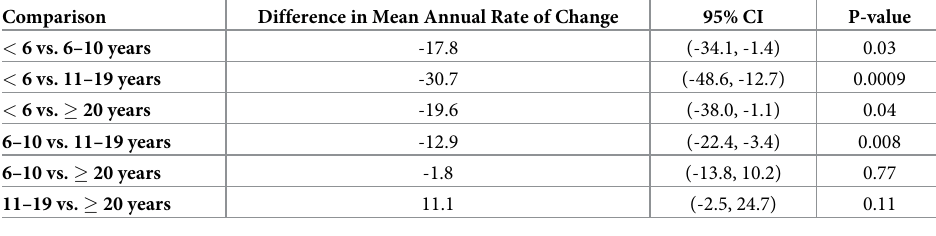
Table 3. Age group comparisons of mean annual rate of change on the 6MWT.